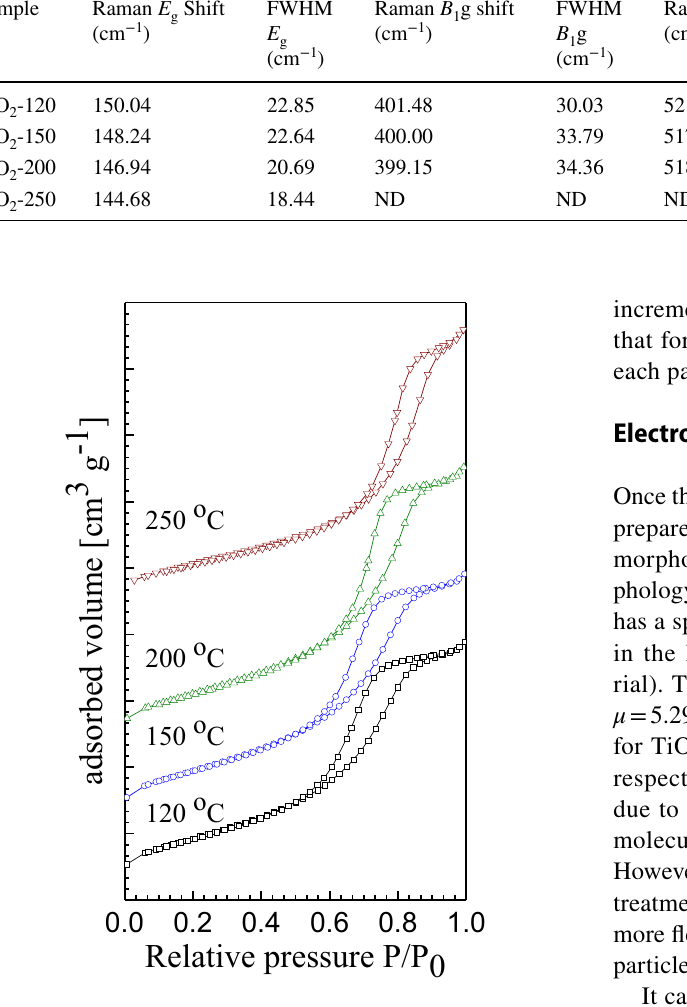
Table 2 Textural properties of TiO orption analysis